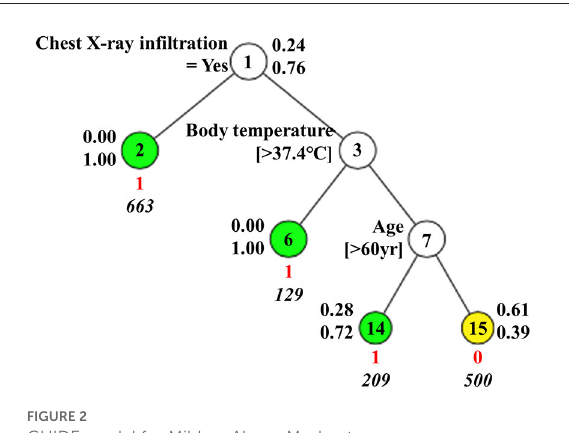
FIGURE2 GUIDE model for Mild vs. Above